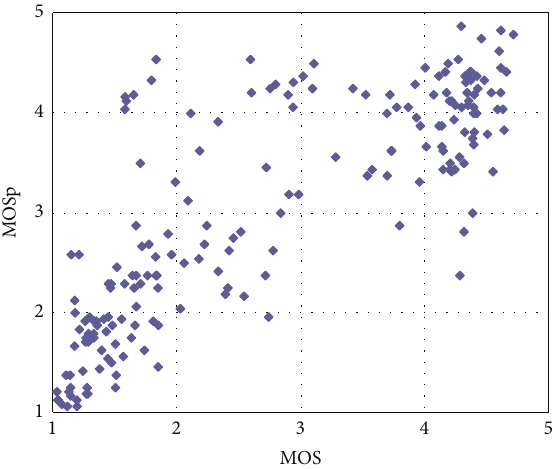
Figure 9: MOSp ( 𝑉 𝑞 ) versus MOS for model